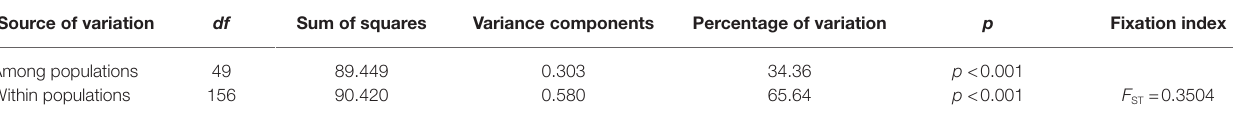
TABLE 2 | Results of analysis of molecular variance (AMOVA) of Lycium ruthenicum populations. Source of variation df Sum of squares Variance components Percentage of variation p Fixation index Among populations 49 89.449 0.303 34.36 p < 0.001 Within populations 156 90.420 0.580 65.64 p < 0.001 F ST =